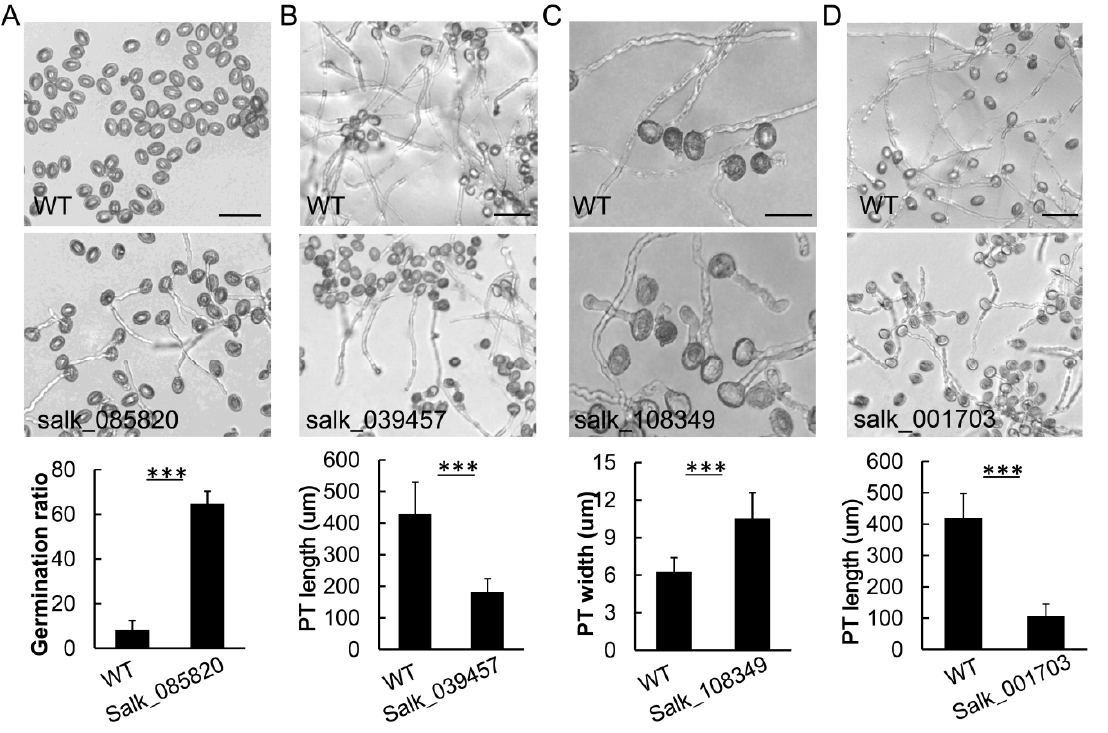
Figure 4. The pollen tube growth defects caused by the T-DNA insertions in four ROP1-associated proteins in Arabidopsis. The knockout line (Salk_085820) of the AAA-type ATPase family protein had promoted rates of pollen tube germination ( A ); The T-DNA insertion line (Salk_039457) in CHX28 led to the inhibition of pollen germination and shorter pollen tubes compared to wild type ( B ). The T-DNA insertion line (Salk_108349) for the EXOSTOSIN family protein caused swollen pollen tubes ( C ). The T-DNA insertion line (Salk_001703) for QUASIMODO2 LIKE 2 exhibited shorter pollen tubes ( D ). Scale bars = 30 µ m in ( A ), 50 µ m in ( B ) and ( D ), 20 µ m in ( C ). *** p < 0.001 (two-tailed T-test), n ≥ 50.